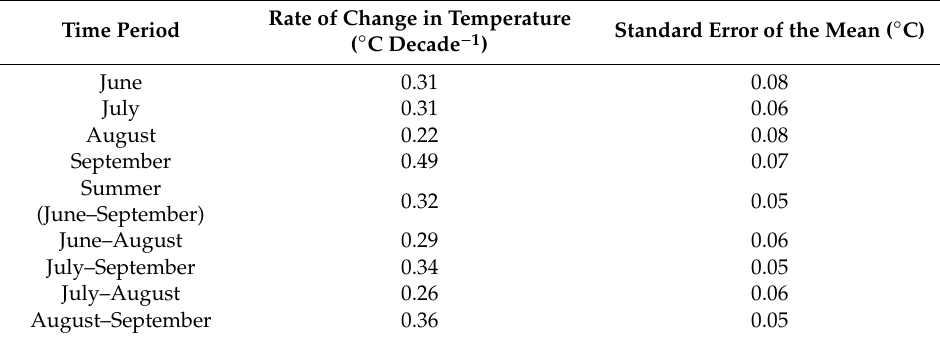
Table 1. Slopes ( ◦ C decade − 1 ) with standard errors of average near-surface water temperatures in lakes of the conterminous United States versus years for di ff erent time periods in the summers of 1981–2018. The summer temperatures represent the average summer temperatures for the months of June through September each year. Slopes for other combinations of 2 or 3 months are also presented.